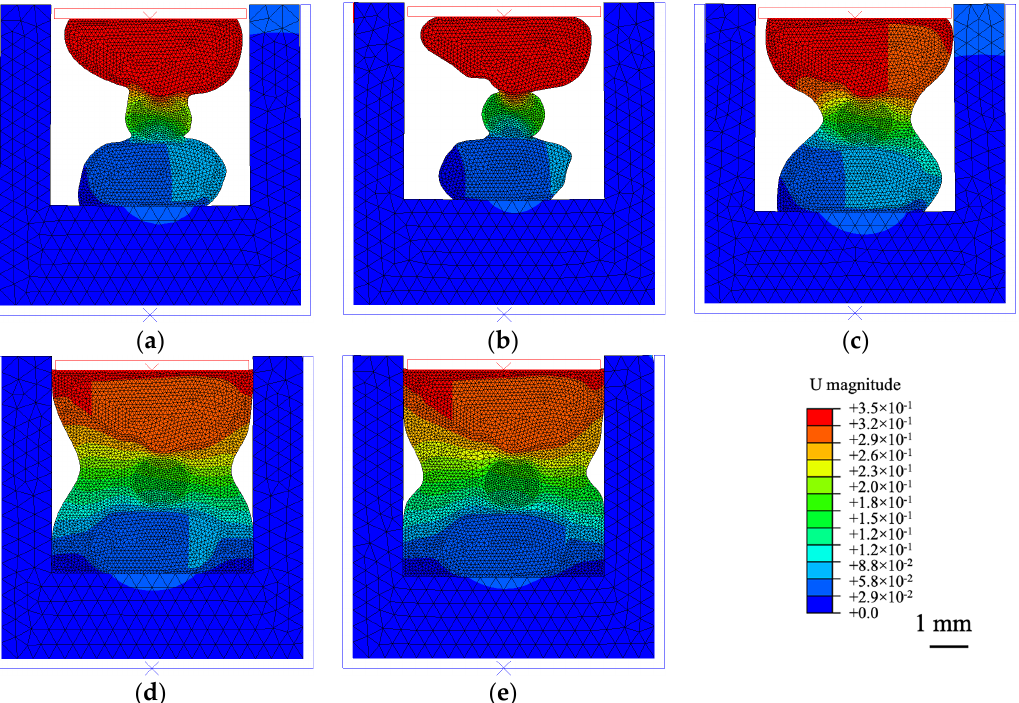
Figure 10. Total displacement U (in mm) in the FE model after applying uniaxial compression for the five variations in the case study altering the area of mortar. From ( a – e ), AR of the capsule after loading: 1.35, 1.30, 1.20, 1.14, 1.12.